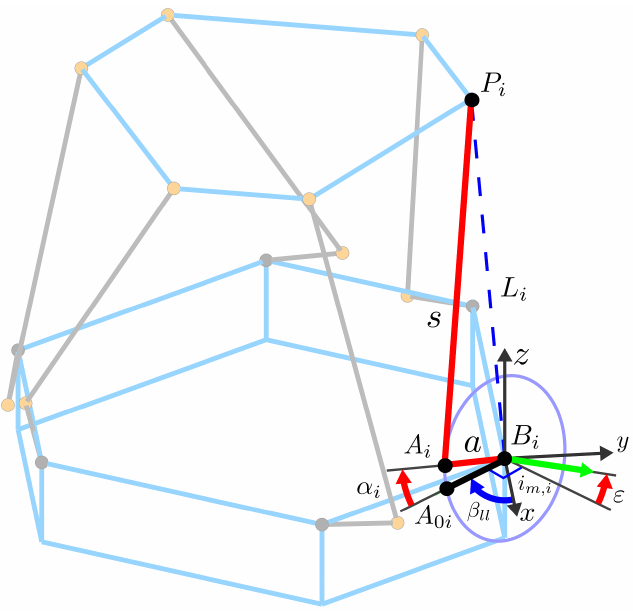
Figure 4. Geometric parameters of one